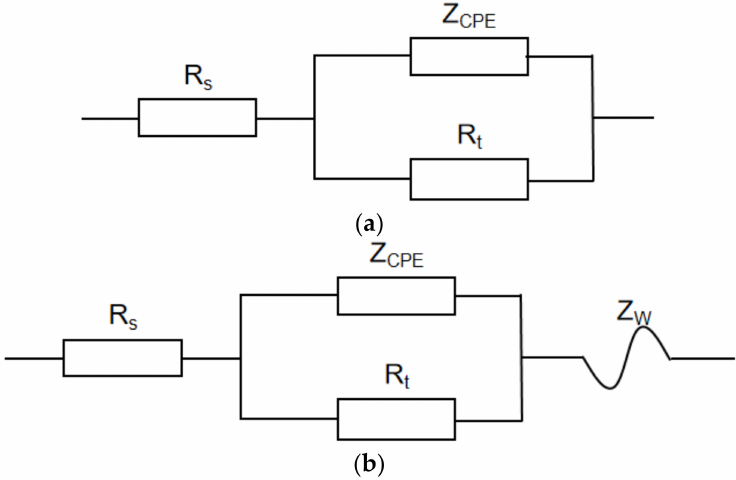
Figure 10. Equivalent circuit diagram for fitting the AC impedance spectrum at different temper- atures and different sulfur contents. ( a ) 0.3%Na 2 S.9H 2 O @ 30 and 60 ◦ C; 3%Na 2 S.9H 2 O @ 30 ◦ C;